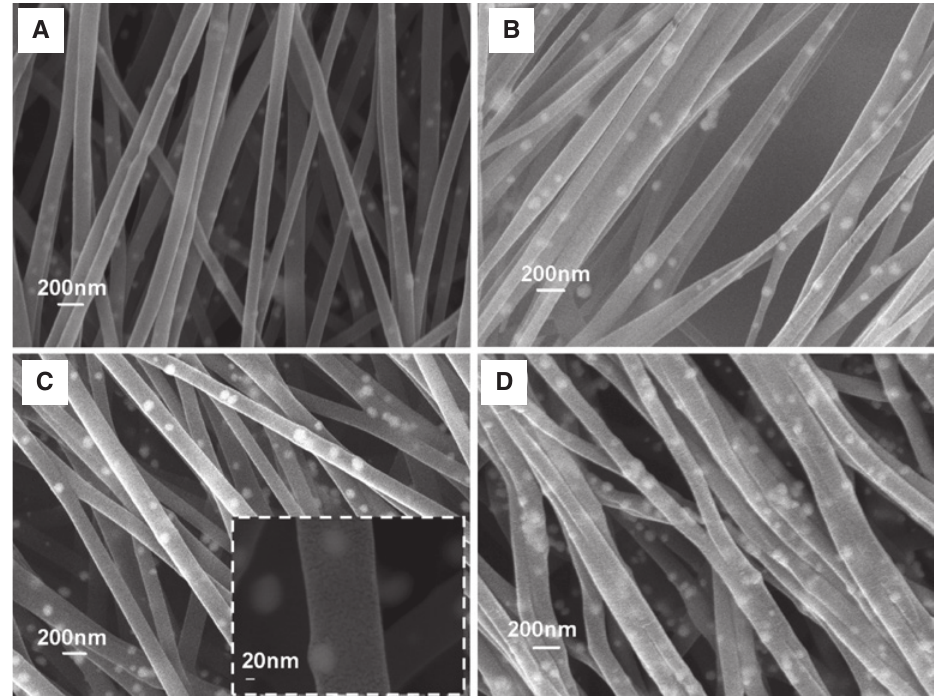
Figure 2: Morphology of aligned PVA@Ag nanofibers. SEM morphology characterization from PVA@Ag nanofibers with volume ratio of (A) 2 (PVA):1 (Ag colloid), (B) 1 (PVA):1 (Ag colloid), (C) 1 (PVA):2 (Ag colloid), (D) 1 (PVA):3 (Ag colloid), respectively. The inset of Figure 2C is the detailed SEM of PVA@Ag